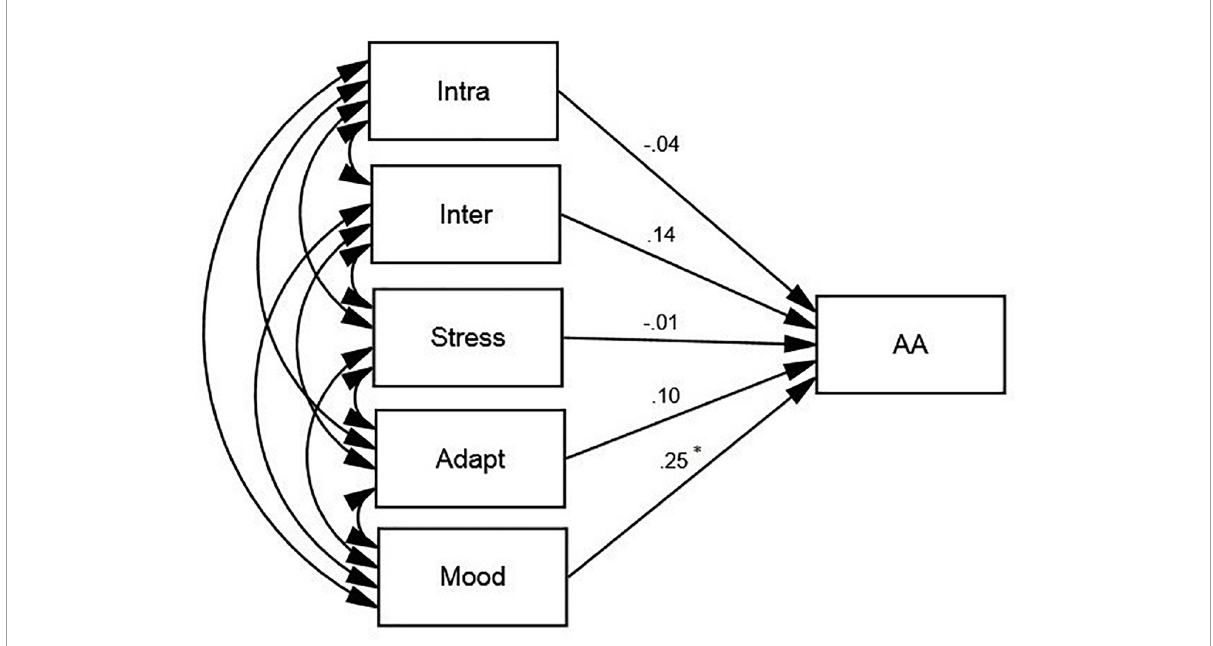
FIGURE3 The schematic representation of the relationships between Academic Achievement (AA) and the subconstructs of EQ (Intra, Intrapersonal; Inter, Interpersonal; Stress, Stress Management; Adapt, Adaptability; Mood, General Mood; ∗ p <